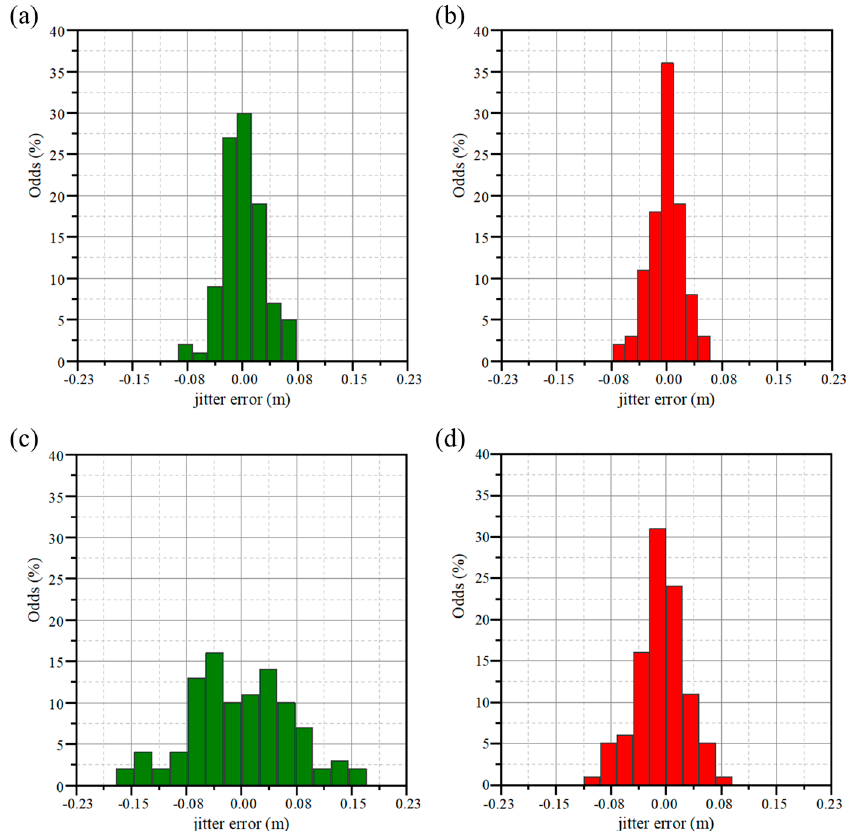
Figure 9. Jitter error under high SNR conditions based on ( a ) SPM and based on ( b ) BDM and under low SNR conditions based on ( c ) SPM and based on ( d ) BDM.